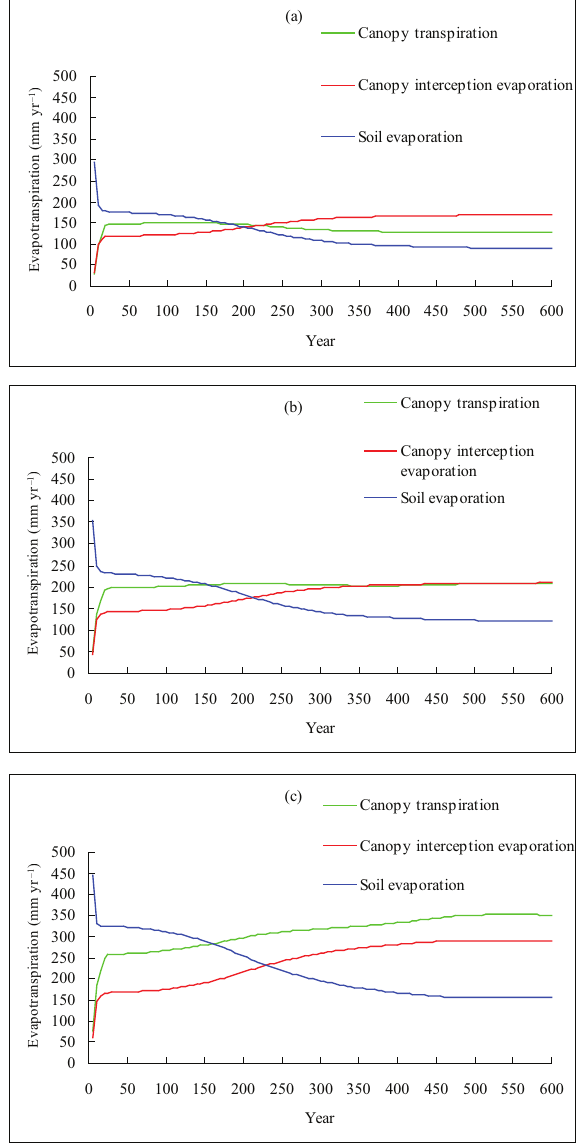
Figure 5. Temporal evolution of transpiration, canopy interception evaporation and soil evaporation: (a) Exp. T; (b) exp. (T+2); and (c) exp. [T+5,